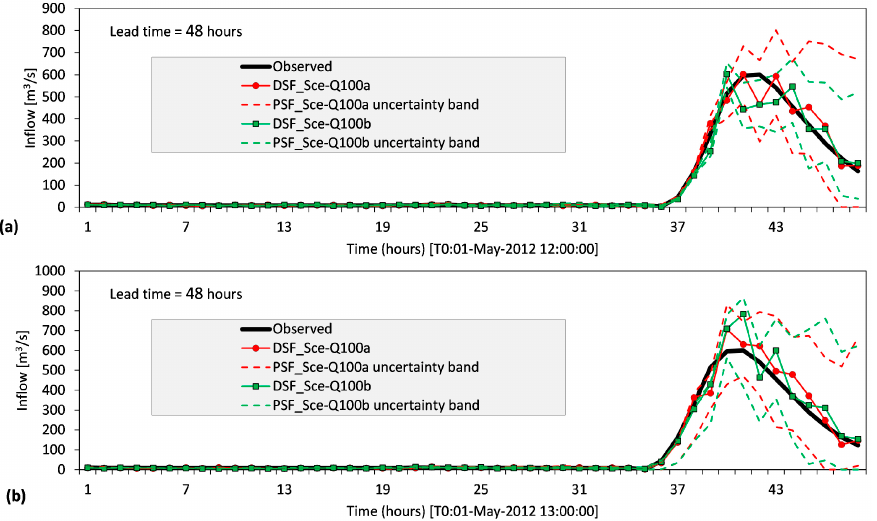
Figure 4. Graphical representation of the scenarios (Sce-Q100a and Sce-Q100b)